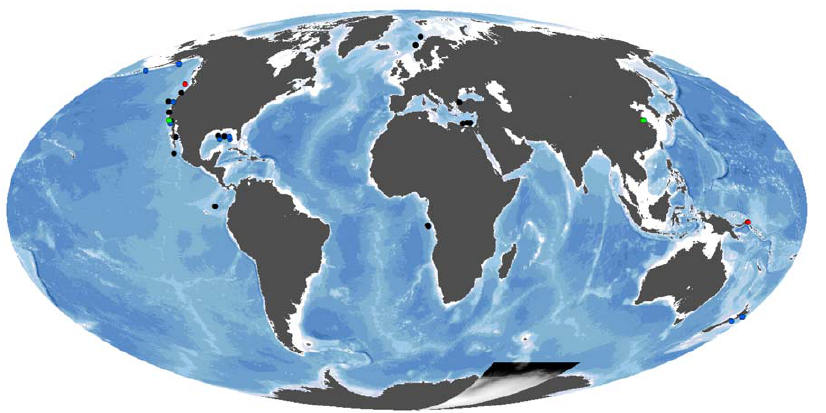
Figure 1. Global distribution of known chemosynthetic ecosystems. Colored dots represent quantitative faunal studies at hydrothermal vents (red), cold seeps (blue), and organic falls (green). Black dots indicate chemosynthetic sites used for comparisons only.